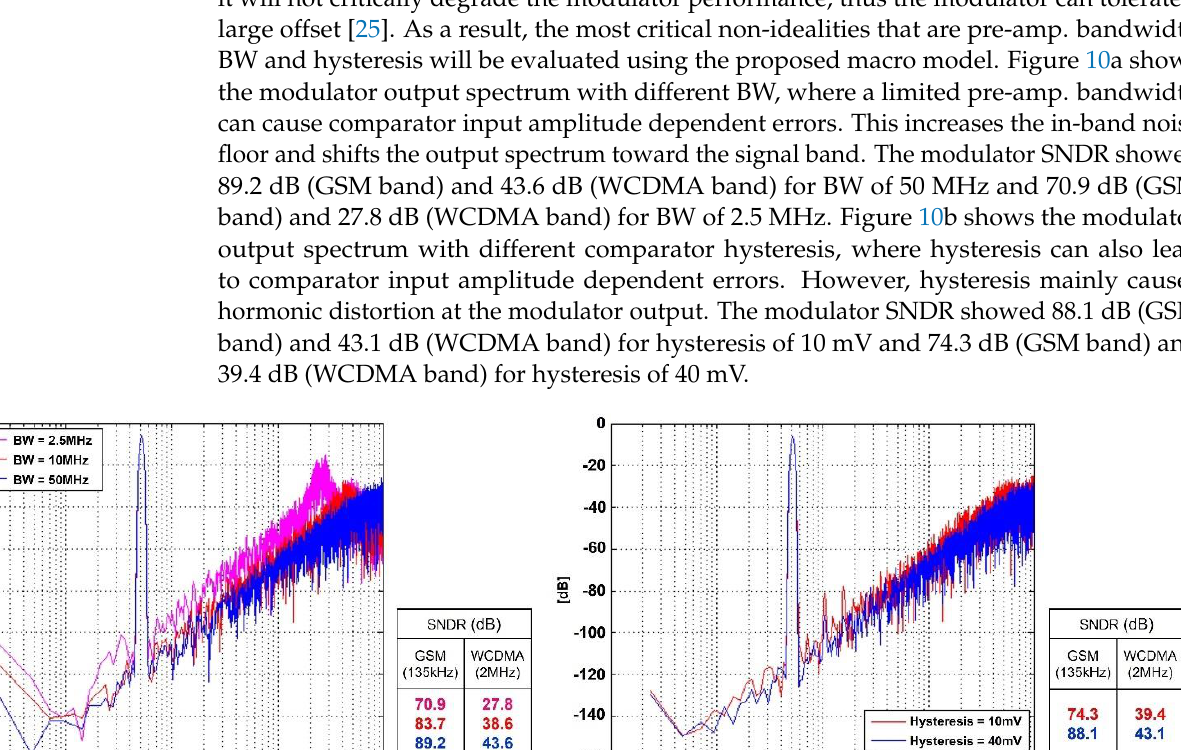
Figure 9. Modulator output spectrum with amplifier non-idealities. ( a ) A o , ( b ) GBW, and ( c ) SR.